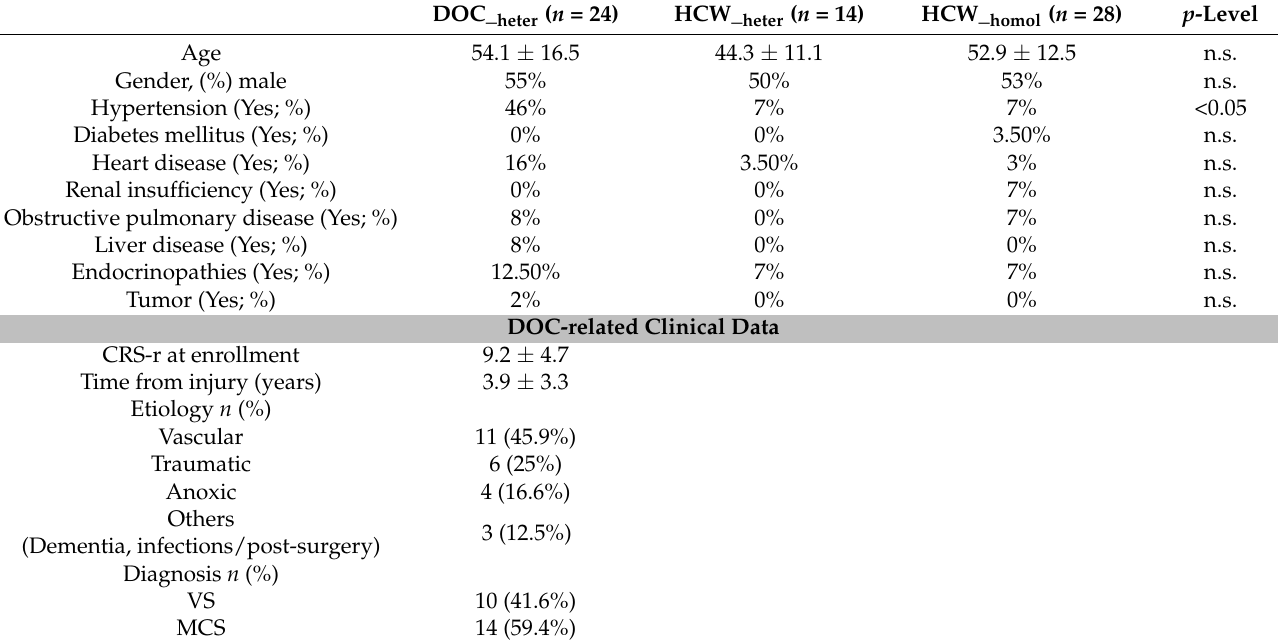
Table 1. Demographic and clinical characteristics of enrolled DOC patients and controls undergoing booster